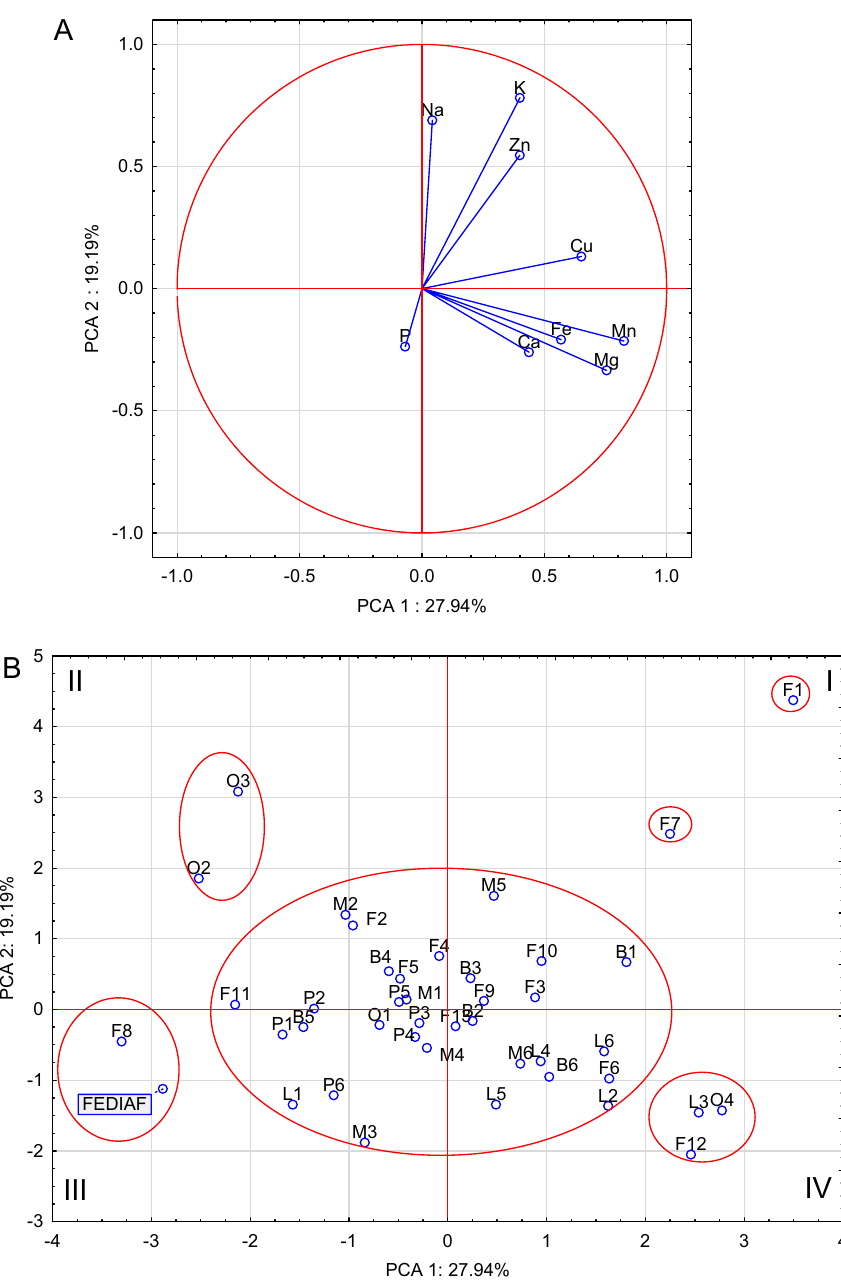
Figure 1. Biplot based on first two principal component axes for mineral composition of analyzed dry dog foods ( A ) and distribution of 41 dry dog foods based on the first two components obtained from principal component analysis ( B